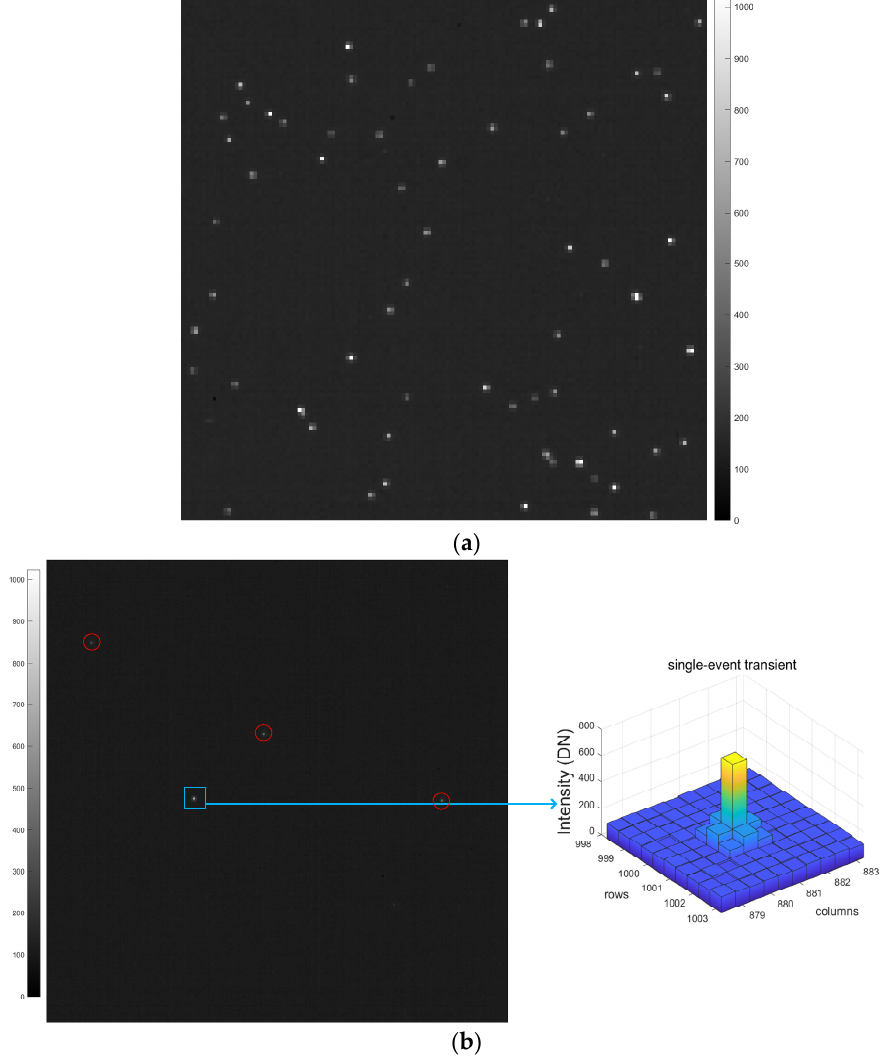
Figure 4. Image containing single-event transient clusters. ( a ) Part of an image collected online during a proton irradiation experiment. ( b ) Part of a star map with single-event transient clusters. The real stars are shown in the red circle and the transient cluster is shown in the blue box.